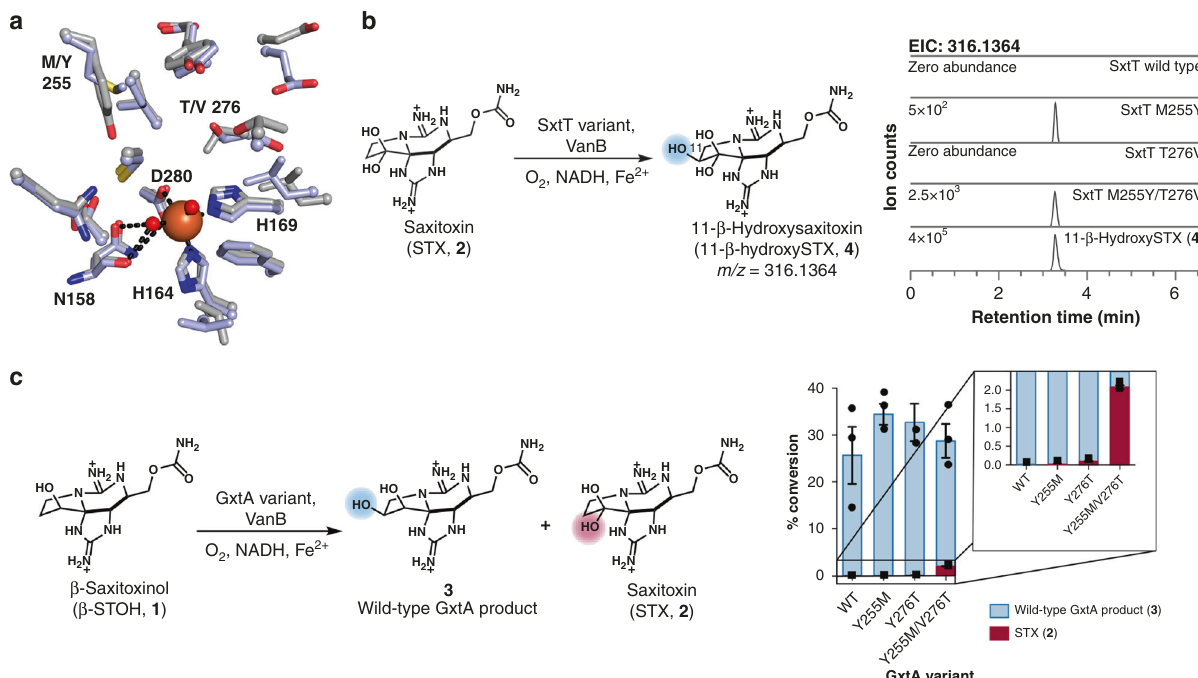
Fig. 3 Biochemical analysis of SxtT and GxtA variants reveals changes in reaction selectivity. a The active sites of SxtT (purple) and GxtA (gray) are relatively similar to one another except for the replacement of SxtT residues Met255 and Thr276 with GxtA residues Tyr255 and Val276. b Reactions of SxtT wild-type and variants with STX ( 2 ). c Reactions of GxtA wild-type and variants with β -STOH ( 1 ) and the mixtures of products generated in these reactions. Data are presented as mean values± SD. Reaction conditions: 5 µ M SxtT/GxtA, 5 µ M VanB, 200 µ M β -STOH ( 1 ), 500 µ M NADH, incubated at 30 °C for 2